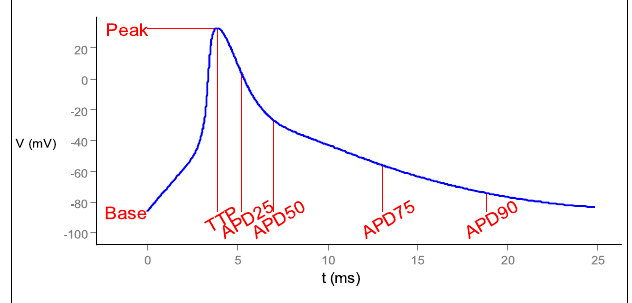
FIGURE 2 | Scalar measures of state-variable trajectories, exemplified by the action potential. TTP, time to peak. APD25, etc.: action potential duration to 25%, etc., return to initial (“base”)